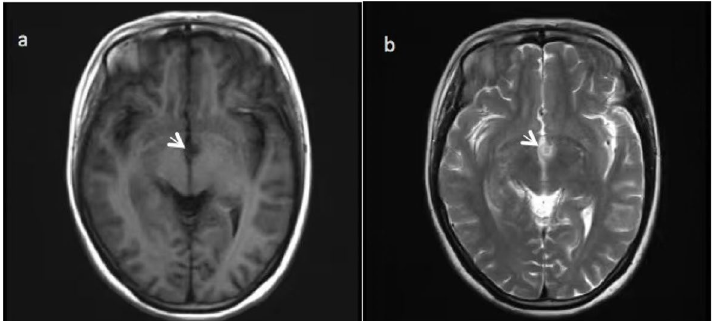
Fig. 4 Postoperative cranial MRI T1WI ( a ) and T2WI ( b